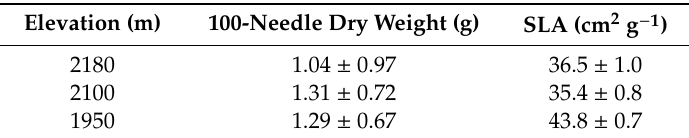
Figure 4. The relationship between temperature and net photosynthesis of fully developed, current-year Pinus cembra needles at the krummholz limit [open circles, tree line (closed squares), and the forest limit (solid circles) assessed in summer (top) and fall (bottom)]. After [48] and [108]. Table 3. The 100-needle dry weight and the specific leaf area (SLA) of current-year Pinus cembra needles at the krummholz limit (2180 m a.s.l.), the treeline (2100 m a.s.l.), and the forest limit (1950 m a.s.l.) on Mount Patscherkofel. After